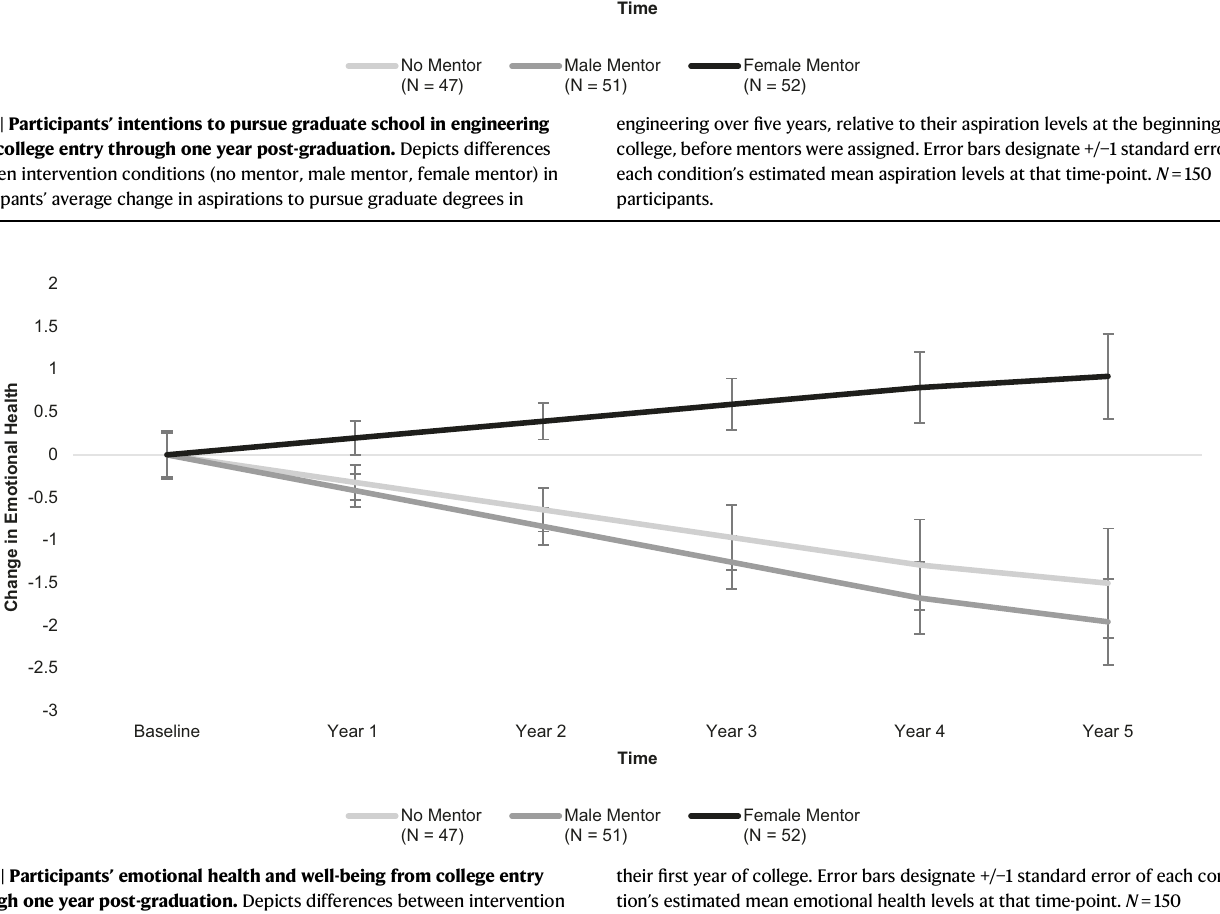
their fi rst year of college. Error bars designate +/ − 1 standard error of each condi- tion ’ s estimated mean emotional health levels at that time-point. N =150